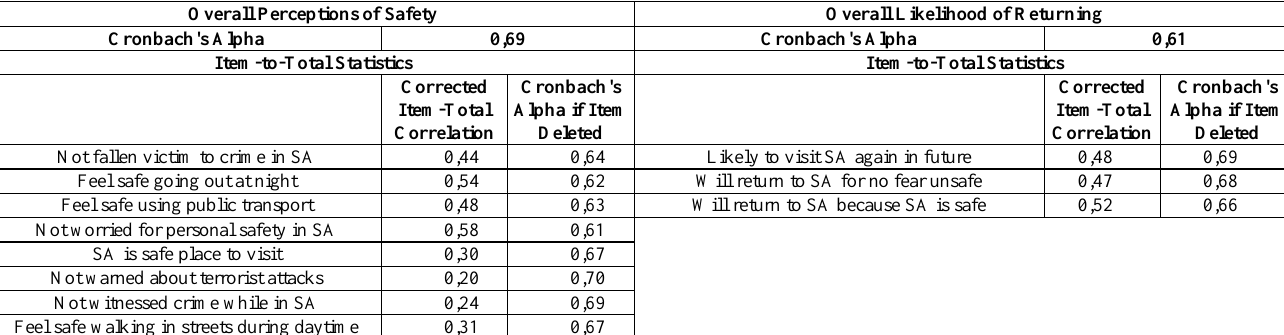
Table 3: Reliability statistics – overall likelihood of returning and overall perceptions of